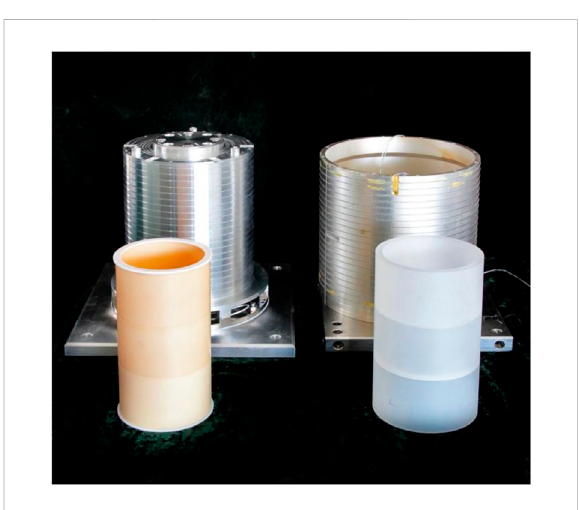
FIGURE 4 Comparison of NMT-loaded and sapphire-loaded cavities (Left: NMT, right: